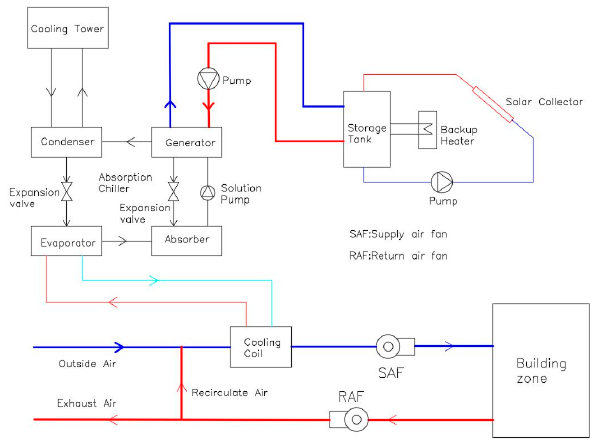
Figure 8. Schematic diagram of the SAC system.